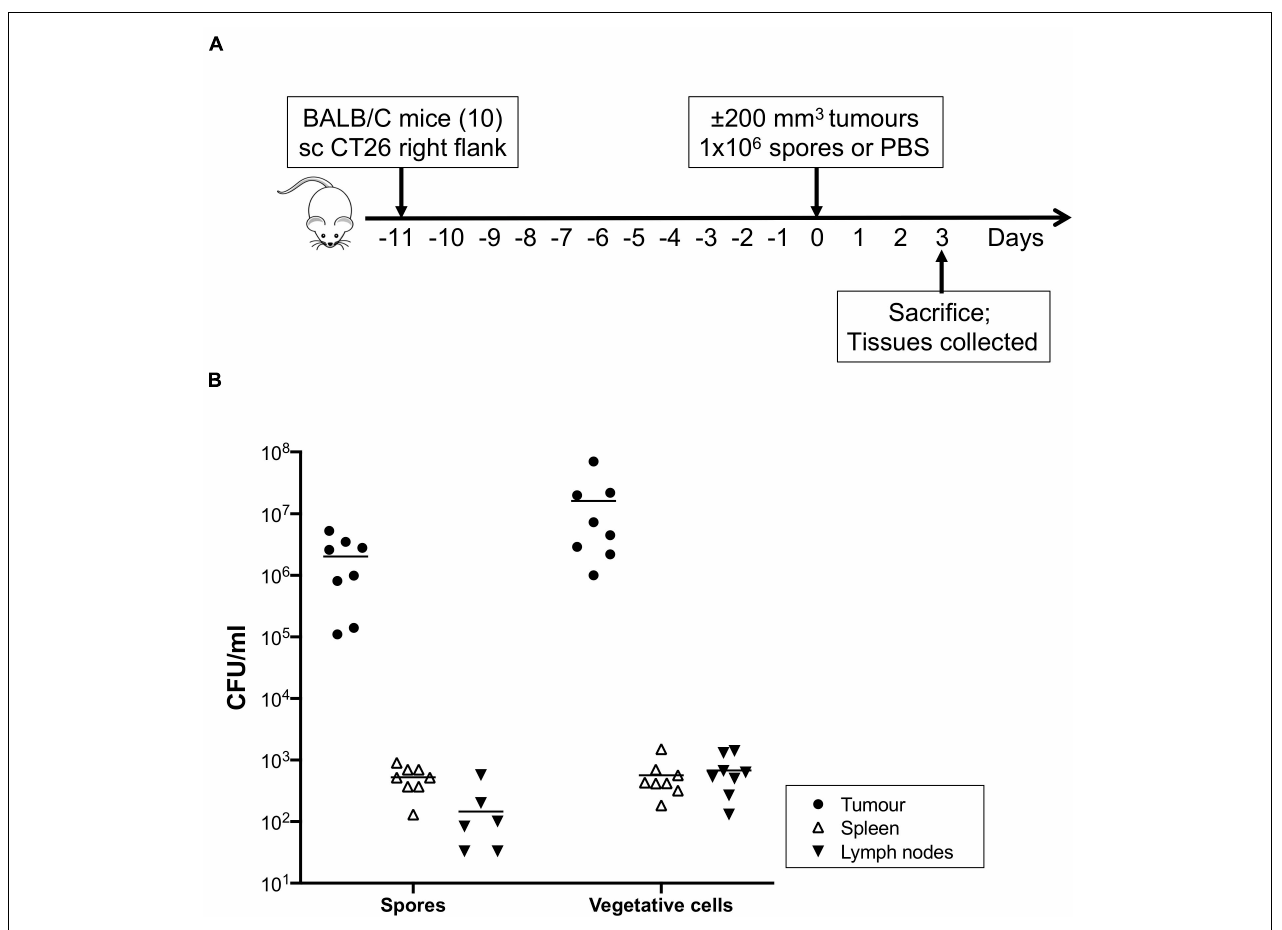
FIGURE 4 | In vivo colonisation study and recovery of bacteria from mouse tissues. (A) Immunocompetent Balb/c mice (ten) were subcutaneously injected with CT26 tumour cells (2 × 10 6 ). When tumour volumes reached approximately 200 mm 3 eight treated animals were given 1 × 10 6 purified C. sporogenes -NT spores. Two control animals were injected with PBS. 72 h after administration of spores, animals were sacrificed and tumours, spleens and lymph nodes were excised and subjected to cell counts. (B) The presence of spores and vegetative cells of C. sporogenes -NT in each tissue (tumour, black circles; spleen, open triangles; lymph nodes, inverted black triangles) was determined by dilution plating on selective media and expressed as colony forming unit